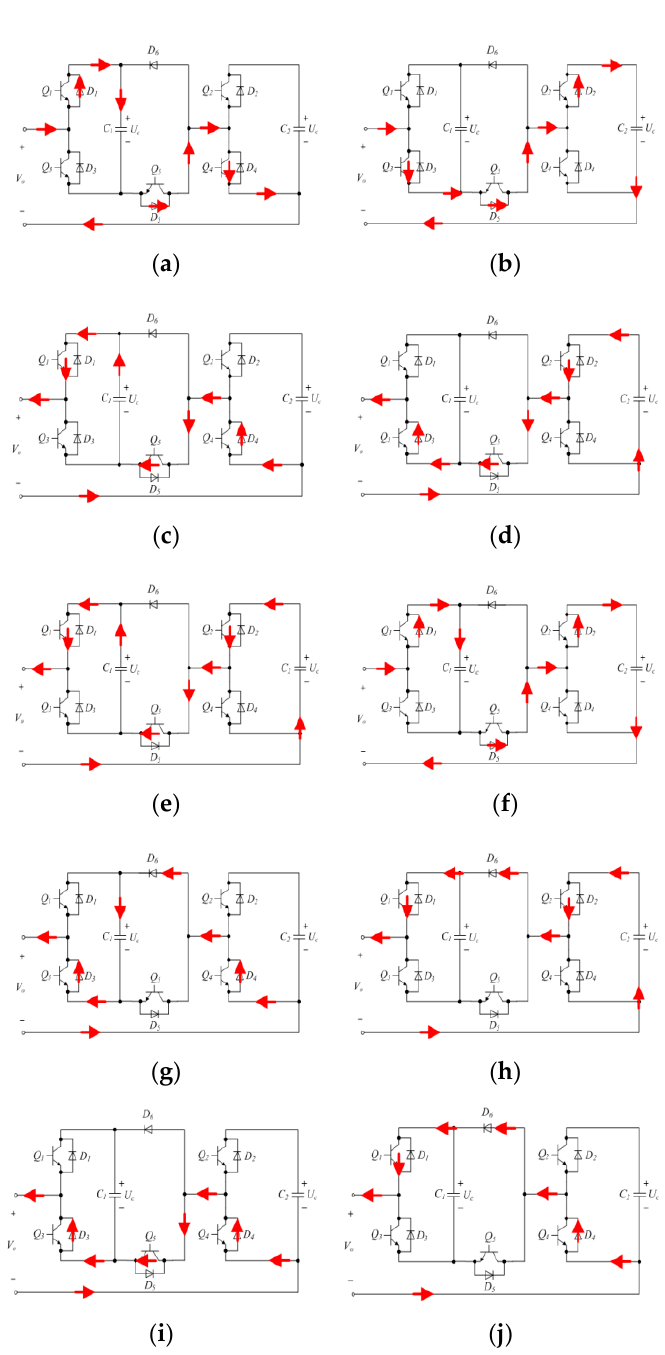
Figure 2. Operational mode, ( a ) C 1 charging, ( b ) C 2 charging, ( c ) C 1 discharging, ( d ) C 2 discharging, ( e ) simultaneous discharging, ( f ) simultaneous charging, ( g ) C 1 charging, ( h ) C 2 discharging, ( i ) converter disconnected @normal, ( j ) converter disconnected @abnormal. Note: ( a – e ) submodule is connected to converter in normal mode, ( f – h ) submodule is connected to converter in abnormal mode. Figure 2i,j show the equivalent circuit when the IHSM is disconnected from the